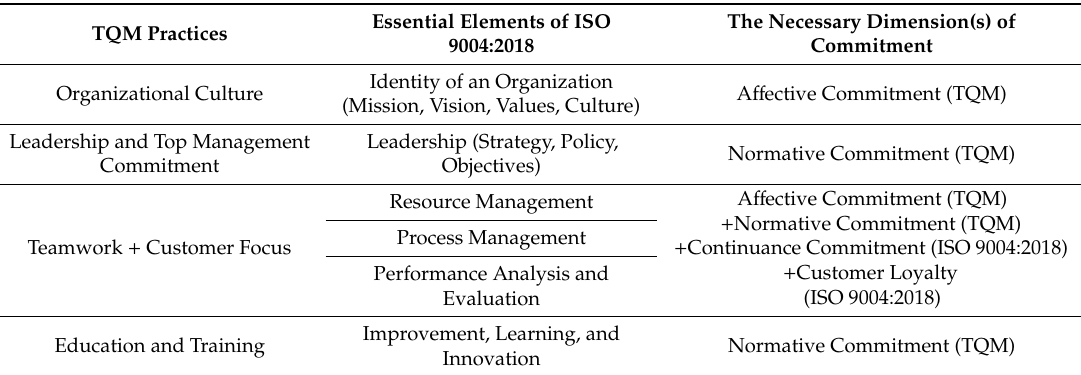
Table 3. Relationships and di ff erences between total quality management (TQM) [37] and ISO 9004:2018 [17], depending on the required types of commitment in each